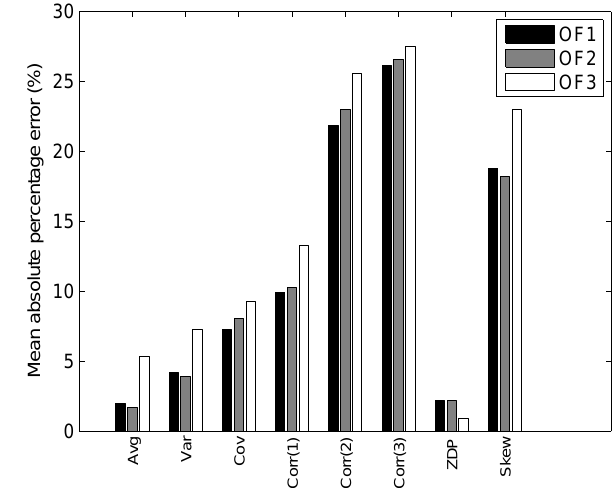
Fig. 10: Mean 10 minute rainfall, average simulation result Fig. 10. Mean Absolute Percentage Error of different fits, averaged over different months and aggregation levels (10min, 30min, 1h, vs. observations 6h, 12h and 24h).